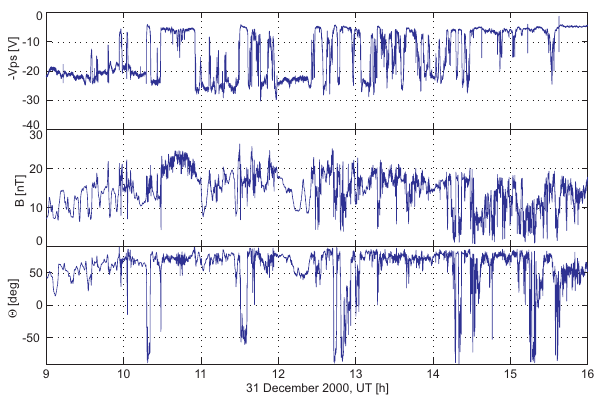
Fig. 1. Observations by Cluster satellite 4 on 31 December 2000. The upper panel shows the potential v ps . This parameter is posi- tively correlated with the density, i.e. a high v ps corresponds to a high density. A v ps of –20, –10 and –5 V corresponds to about 0.8, 2 and 20 particles cm − 3 . The middle panel displays the magnetic field from FGM, and the bottom panel shows the elevation angle of this field in GSE coordinates (so that 90 ◦ corresponds to a strictly northward